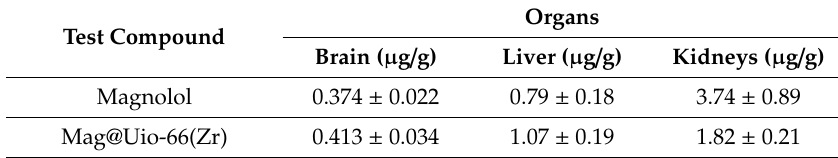
Table 2. Summary of the mean magnolol concentration (µg/g) of magnolol and mag@Uio-66(Zr) in the brains, livers, and kidneys.